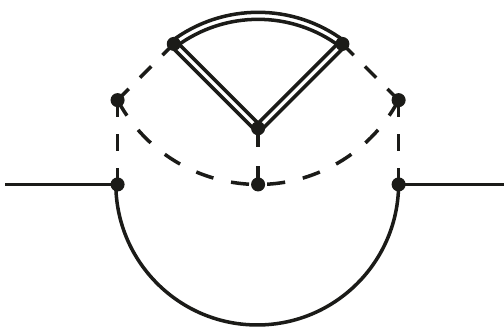
Figure 2 . Integral family d4L456 . Dashed, solid and double lines represent scalar propagators of mass 0, m 1 and m 2